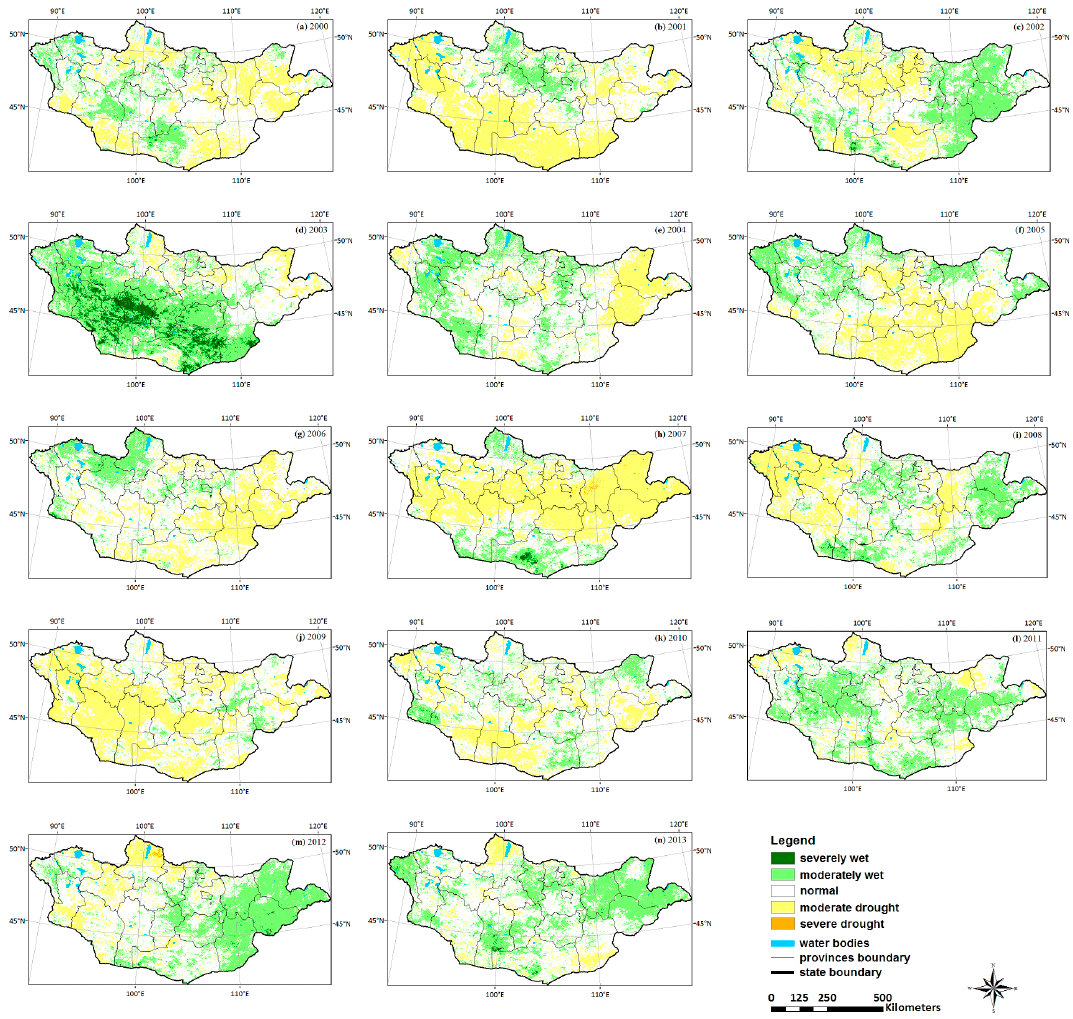
Figure 3. ( a – n ) MDSI anomaly distributions during the growing season for the years 2000–2013: The MDSI anomaly was computed as the standardized Z terms represented in Equation (6).